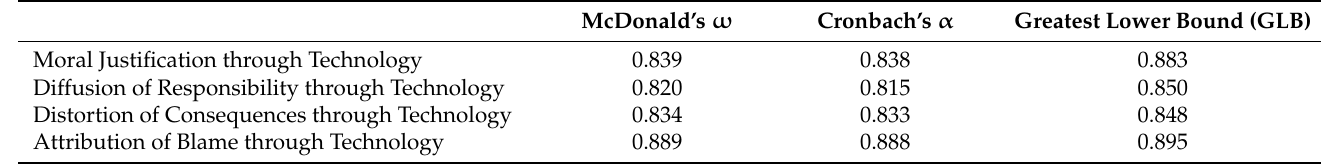
Table 4. Evidence of reliability according to